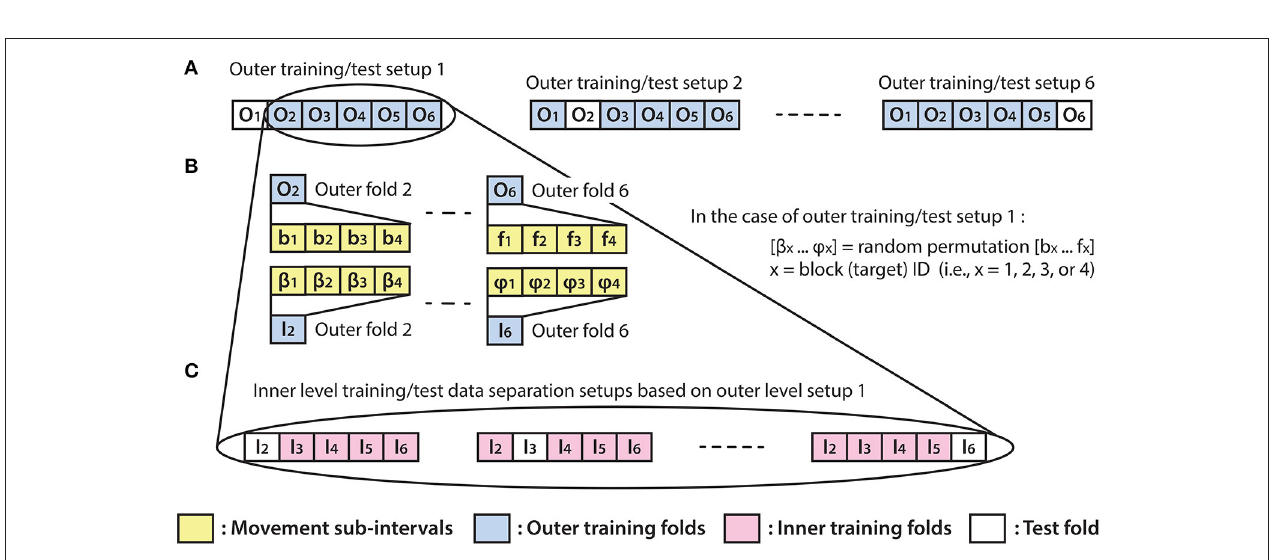
FIGURE 4 | Inner fold structures. Illustration of the six training/test data separation setup options for the applied inner-outer (nested) cross-validation technique using six outer folds and five inner folds. (A) The outer fold setup involving six different training/test data separation options. Each of the six setup options involves five outer folds for training purposes and one outer fold for calculating the final test results. (B) Illustration of the outer fold training data re-distribution method for the data structure in the inner fold level of the selected outer fold. (C) Illustration of the inner level training/test data separation options based on the outer setup option which uses outer folds 2–6 for training and outer fold 1 for test